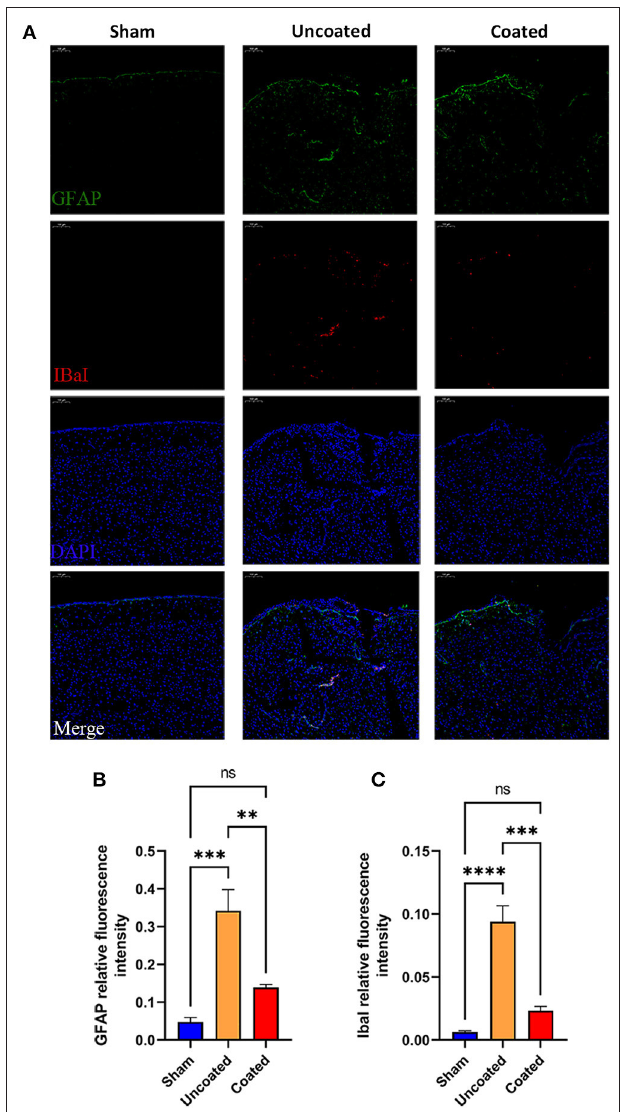
FIGURE 7 | Histology study to determine the inflammation response in different type of electrocoagulation at the 7th day postoperatively. (A) Representative fluorescent images (magnification: × 10). IbaI + (B) and GFAP + (C) relative fluorescence intensity in three treatment groups ( n = 4). ANOVA, ns p > 0.05, ** p < 0.01, *** p < 0.001, and **** p <